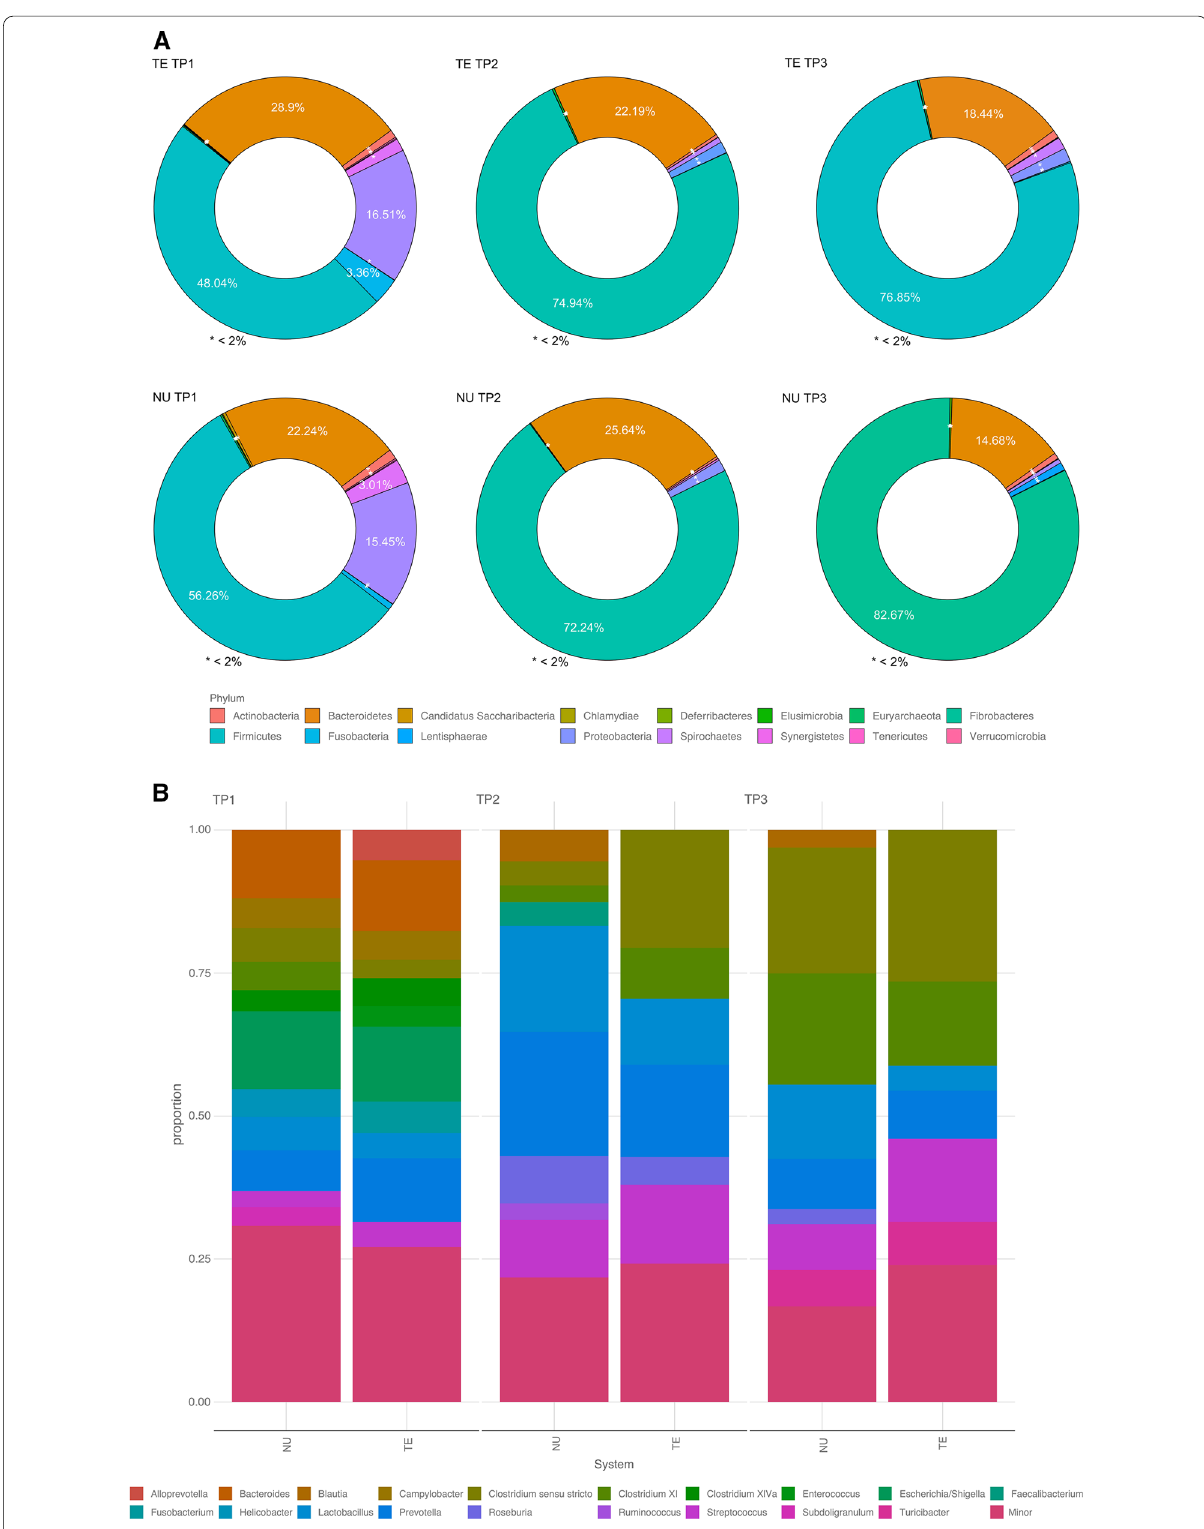
Fig. 1 Relative abundance of microbiome taxa for two systems at three time points. Relative abundance of microbiome taxa at Phylum ( a ) and Genus level ( b ) of Purebred (NU) and Crossbred (TE) at three time points: weaning (TP1), mid test (TP2), and off test (TP3) of the feeding